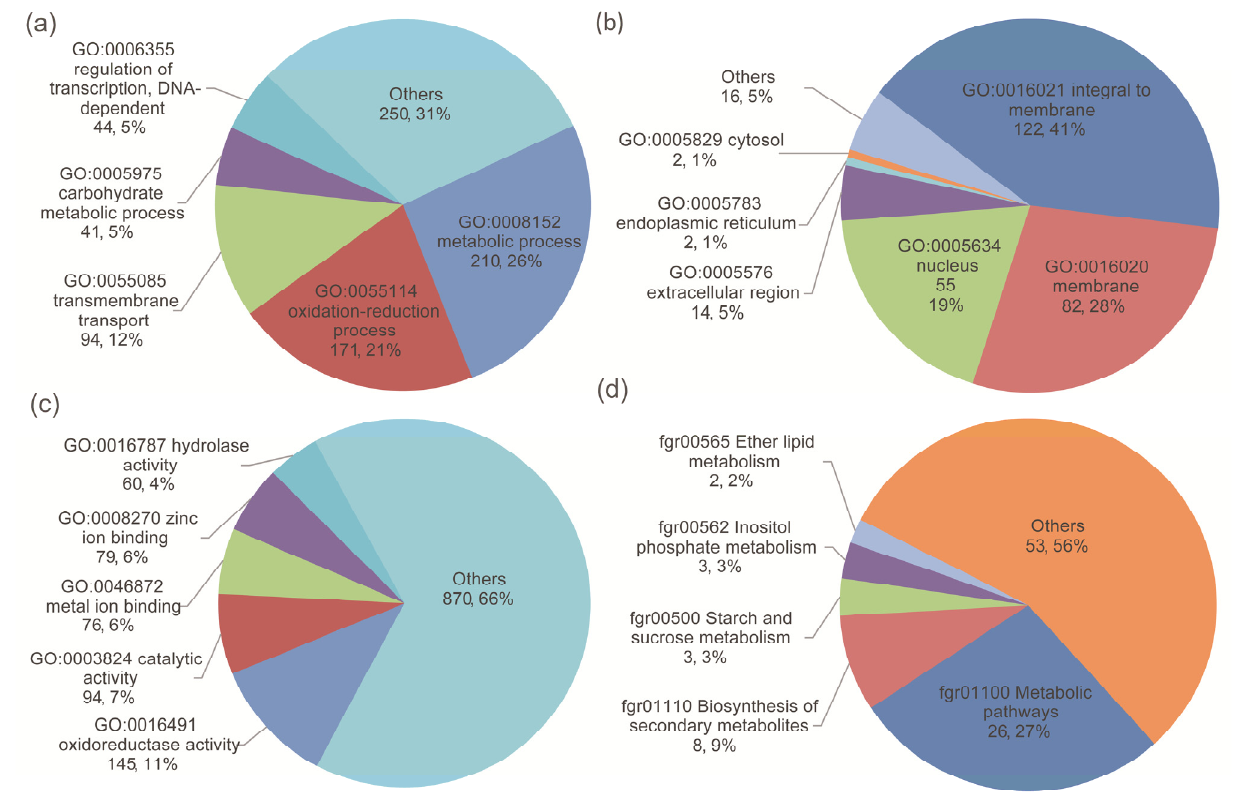
Figure 4. The DEGs were annotated with ( a ) biological processes, ( b ) cellular components, ( c ) molecular functions, and ( d ) KEGG pathways. The first and second numbers in each label are the number and percentage of DEGs annotated,